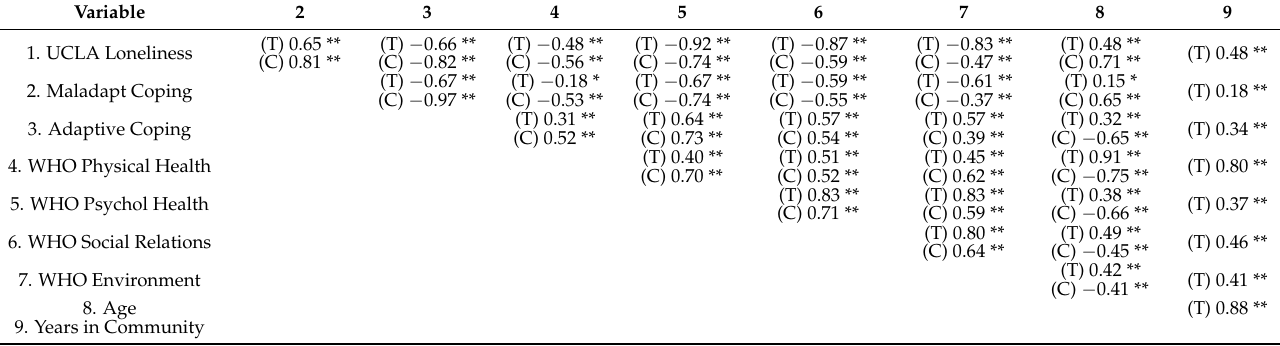
Table 3. Pearson correlations among UCLA Loneliness Scale, Brief COPE scale (maladative and adaptive coping), and subscales of WHO Quality of Life for the transgender (T: N = 200) and cisgender (C: N = 100) subsamples.